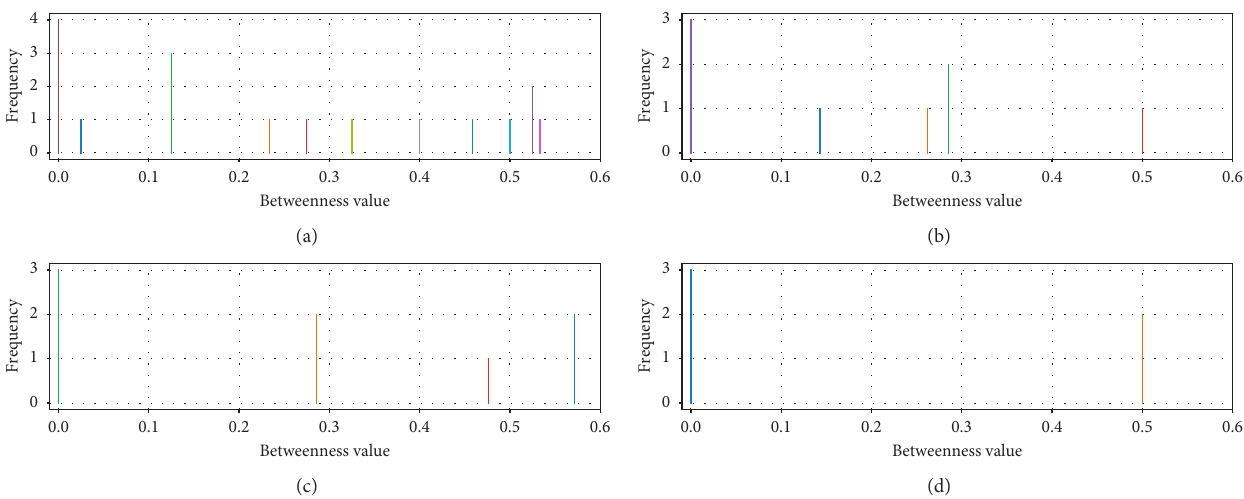
for 48 real-world networks. 50%